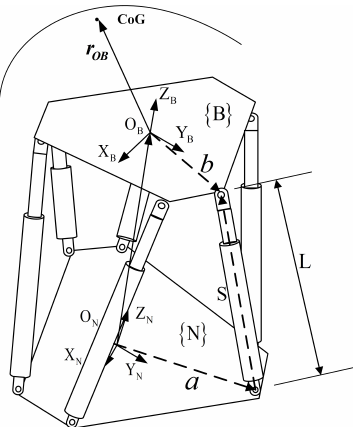
Figure 1. The geometric structure of a general G-S motion